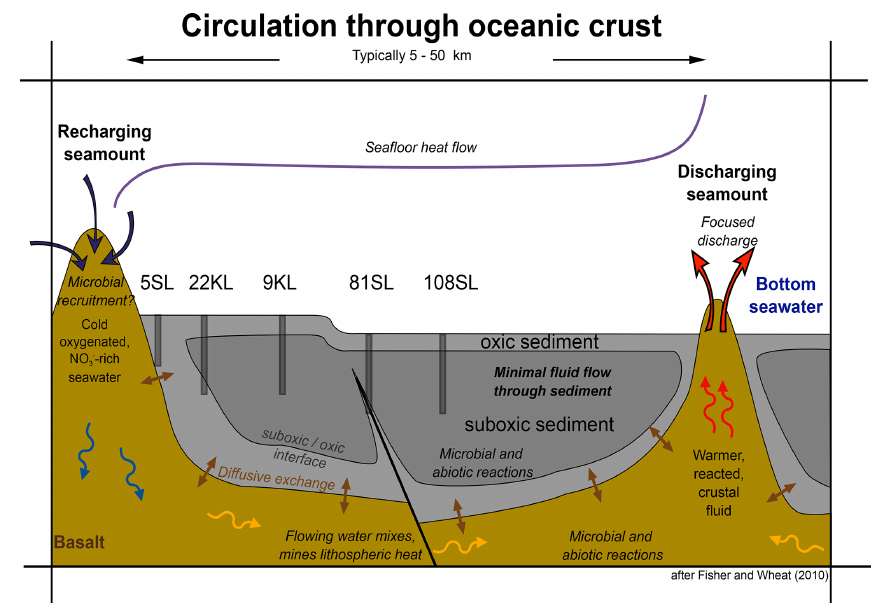
Figure 7. Model of fluid circulation in the basaltic basement, diffusive exchange with the sediment and the sediment oxidation state. Note the influence of faults. Representative cores taken during SO240 are placed such that their geochemical profiles match with the model (modified from Fisher and Wheat,